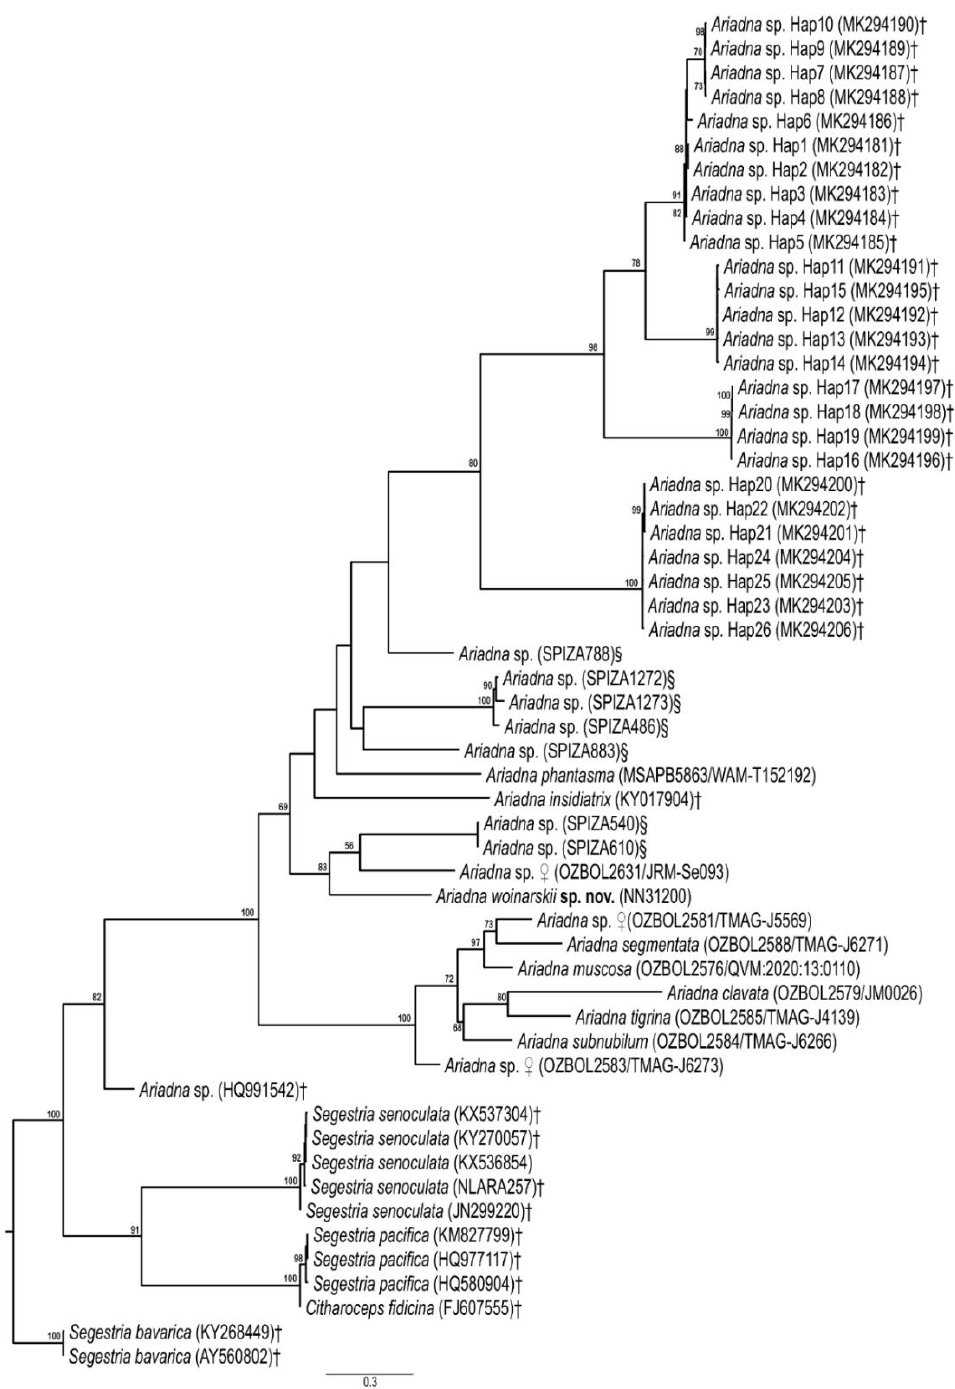
Figure 1. Maximum likelihood tree of the mitochondrial DNA COI gene of all 45 Ariadna sequences used and 11 outgroup taxa. Included are 21 Ariadna species, including the newly described A. woinarskii sp. nov. Bootstrap support values greater than 50% are shown at each node. Details for all new sequences are available in Table 1, and undescribed species with only females are indicated ( ♀ ). GenBank accessions ( † ) and BOLD process IDs (§) are indicated. The Citharoceps fidicina sequence obtained from GenBank is likely a misidentification.